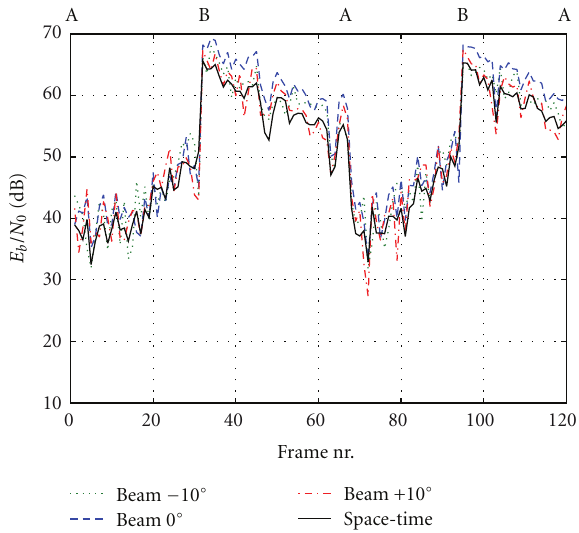
Figure 7: E b /N 0 along the line-of-sight path, with receiver diversity (MRC) for − 10 ◦ , 0 ◦ , and +10 ◦ beams and for the space-time code. Labels on top indicate locations on the floor plan.